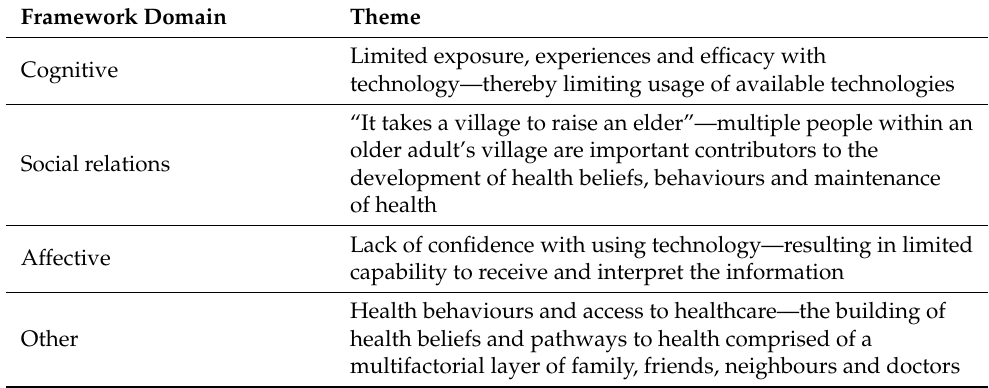
Table 4. A summary of major qualitative themes mapped to the Digital Literacy Framework domains and